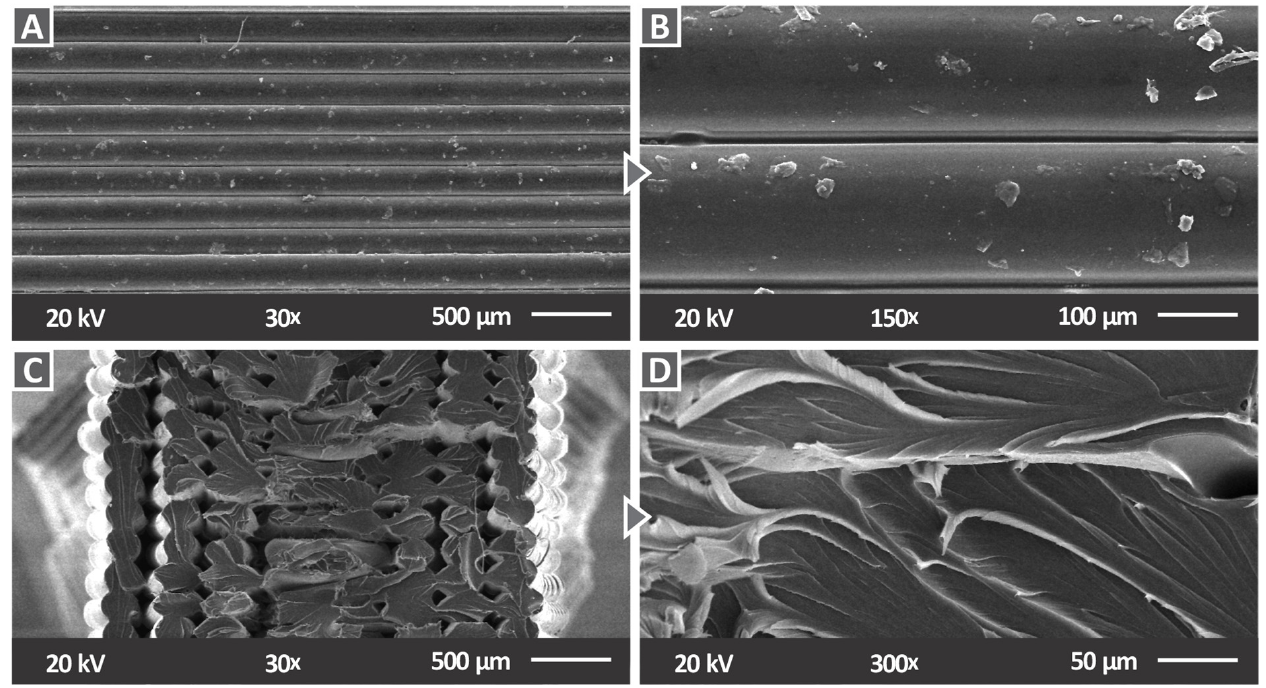
Figure 13. SEM images for pure PC: ( A ) side surface with 30× magnification, ( B ) side surface with 150× magnification, ( C ) fracture surface with 30× magnification, and ( D ) fracture surface with 300× magnification.